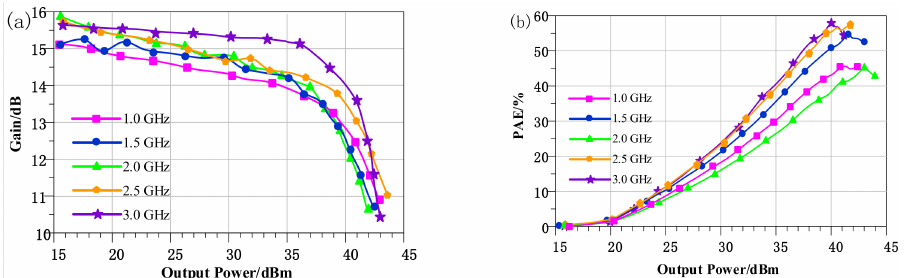
Figure 15. The measured results of the proposed PA. ( a ) Output power & Gain; ( b ) Output power & PAE.